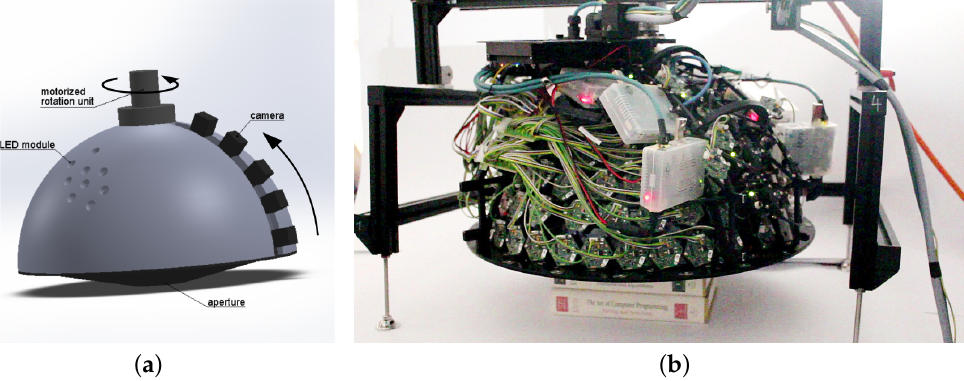
Figure 3. ( a ) The conceptual scheme of our device, consisting of one rotational motion around the z-axis of the hemisphere and one linear motion that approximates to the rotational movement of the six cameras along the meridian; ( b ) assembled device with electronics without carbon cover and servo motor during